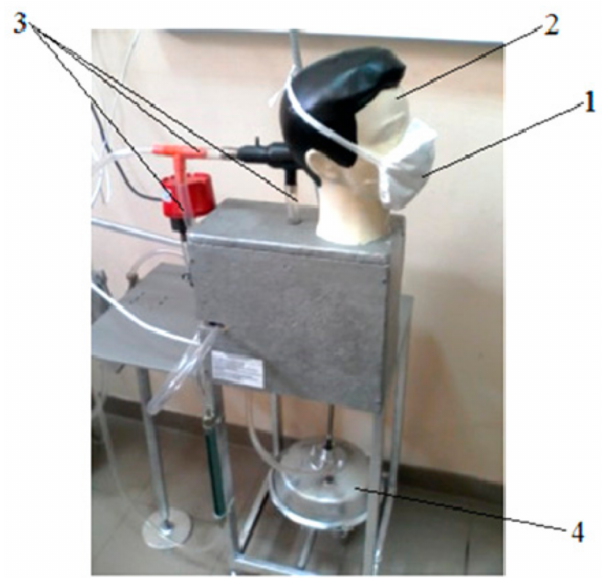
Figure 2. External view of the installation for determining the pressure drop in the filter respirator: